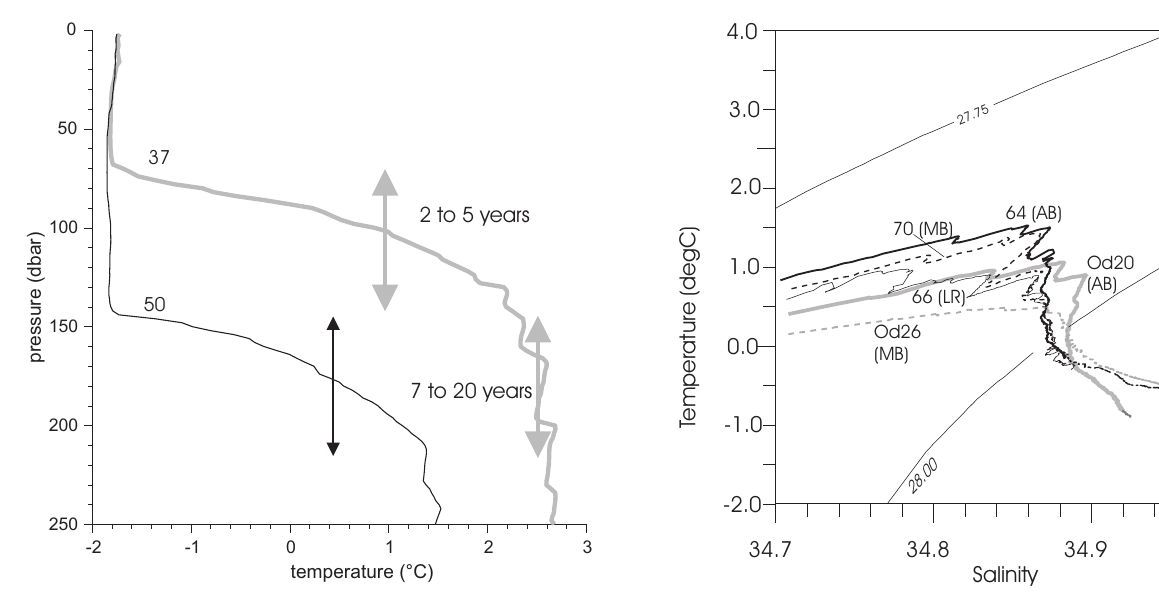
Fig. 8. Temperature profiles of the mixed layer and the upper At- lantic water layer in the boundary current north of the Kara Sea (37) and at the Nansen Gakkel Ridge (50). The arrows show the mean temperatures over a 70m thick layer and the cooling times to reach the temperature of station 50 if the respective layers of station 37 were exposed to 1–3W/m 2 .